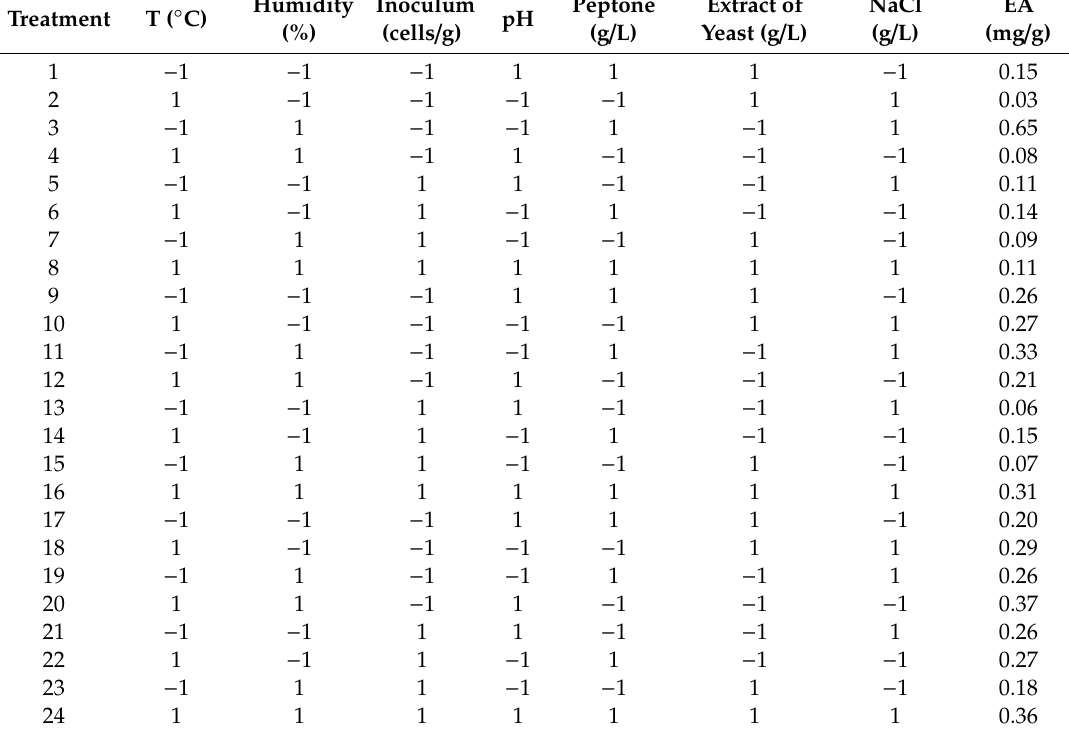
Table 2. Plackett–Burman experimental design for the evaluation of solid state culture (SSC) conditions of pomegranate residues with Saccharomyces cerevisiae